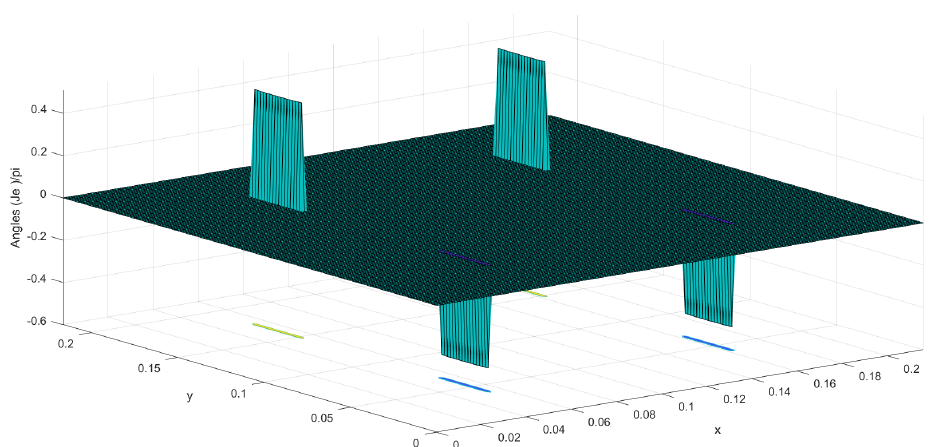
Figure 8. Current J e ’s phase (or Angle) of a symmetry configuration with a magnetic wall along (ox) and a magnetic wall along (oy): the amplitudes of the excitations are 11 − 1 − 1 (MoM-GEC method).